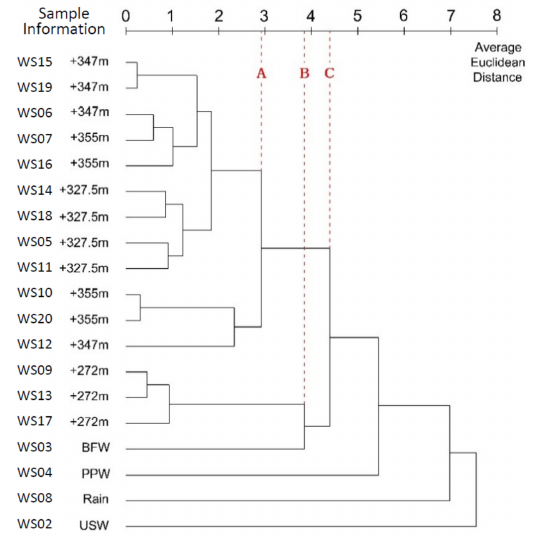
Figure 11. Dendrogram of data through between-groups linkage.